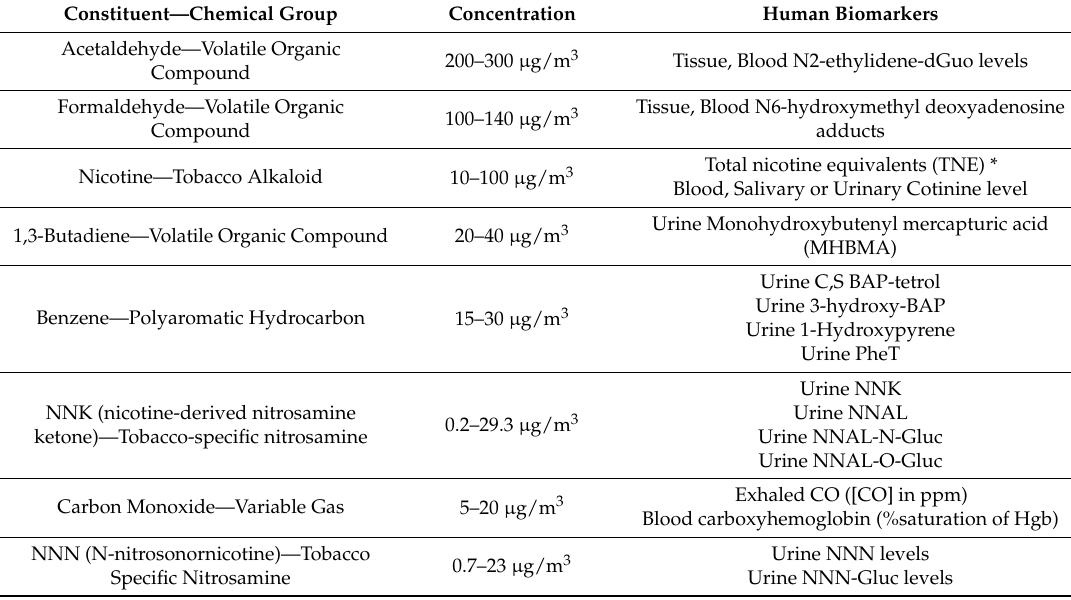
Table adapted from: (4) Second Hand Tobacco Smoke. IARC Monographs. International Agency for Research on Cancer. WHO. 2004; (5) Chang et al. Biomarkers of Tobacco Exposure: Summary of an FDA-Sponsored Public Workshop. Cancer Epidemiol Biomarkers Prev. 2017 Mar; 26(3):